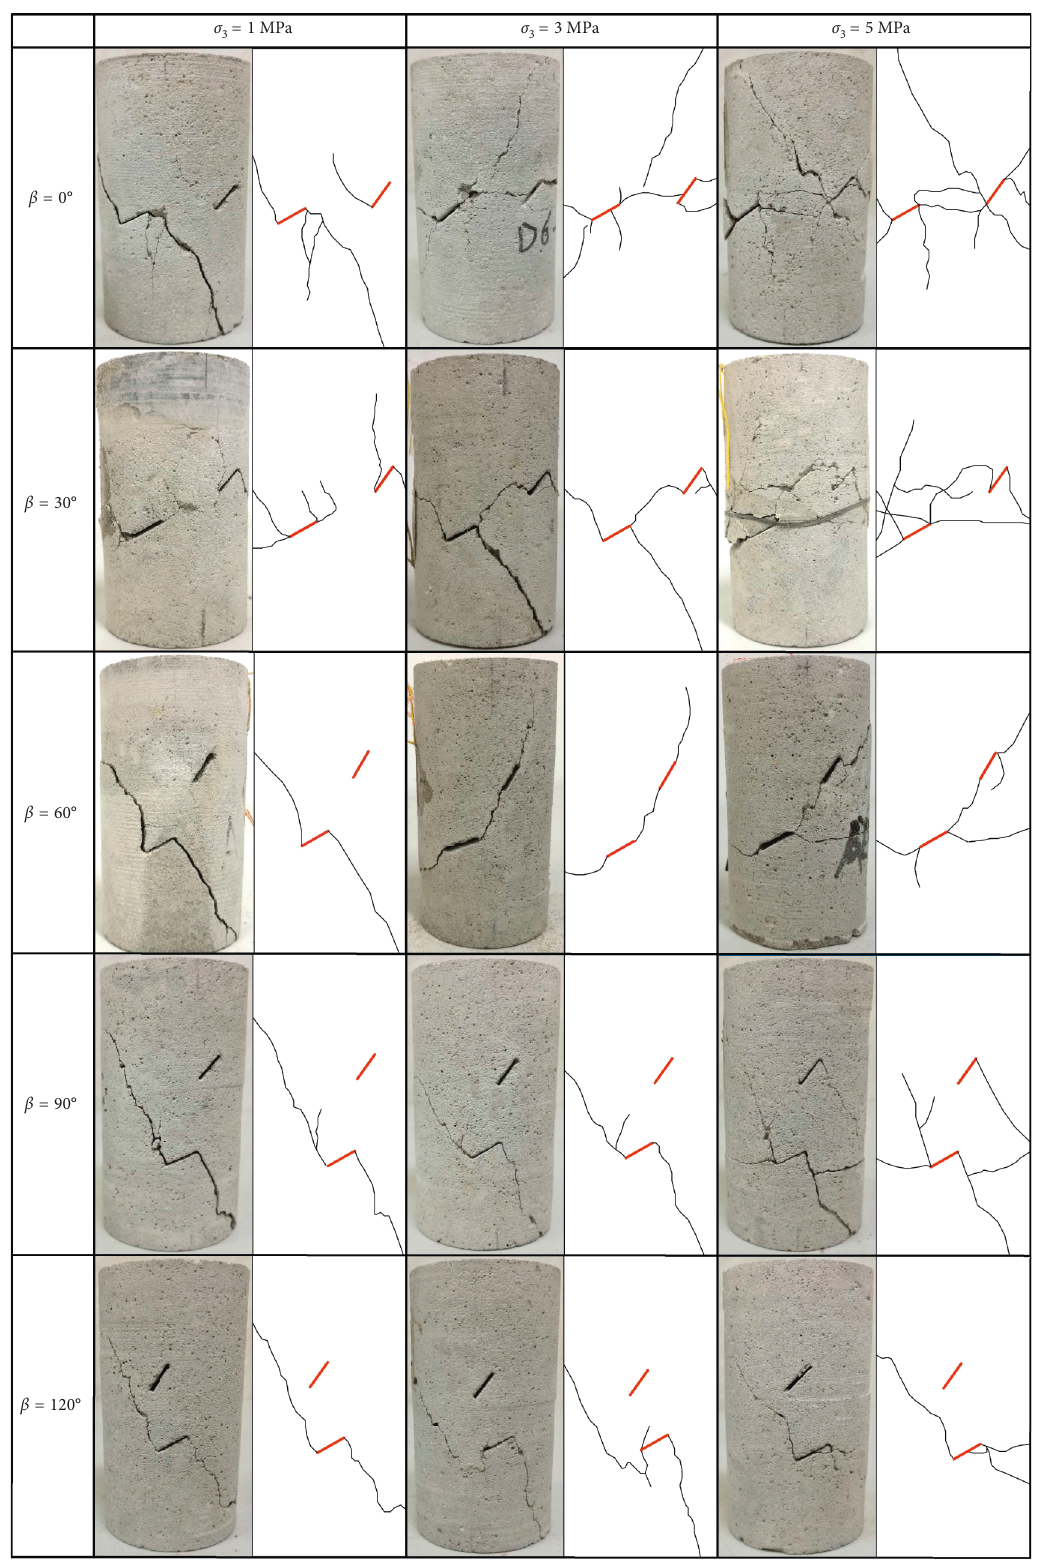
Figure 9: Failure modes of the specimens with a geometry of 20-30-60- β and with different bridge